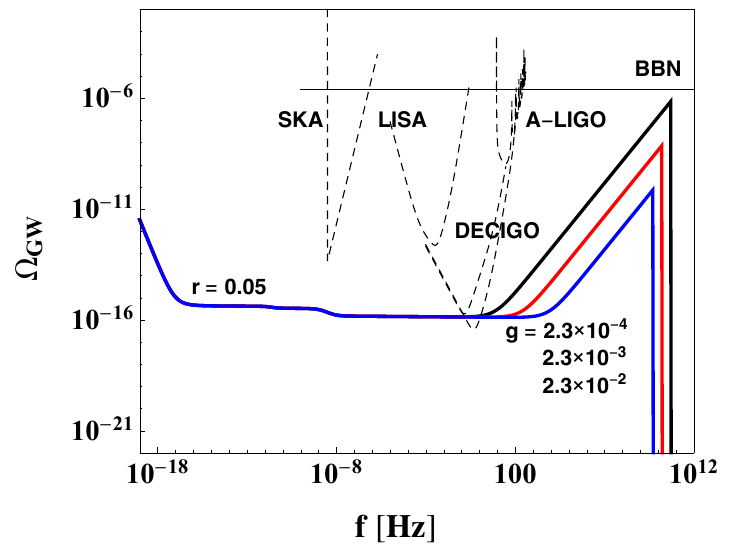
Figure 9. The GW spectrum versus the frequency in Hz for the paradigm of quintessential inflation. The blue tilt in the spectrum is visible on the high-frequency side due to the presence of a long kinetic epoch. Instant preheating is assumed as the reheating mechanism with coupling constant g (consistent with nucleosynthesis constraint); see Section 2.2 and Ref.